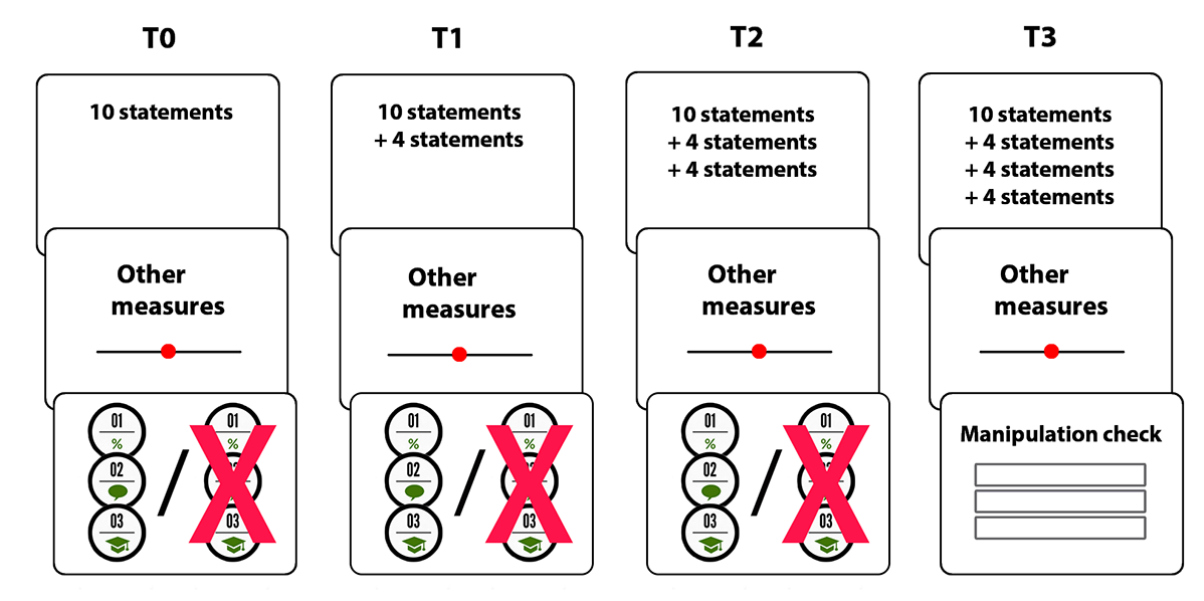
Figure 1. Flowchart of the main elements of the procedure per wave. Participants first completed the measure of belief accuracy, then completed other measures, and, finally, were exposed to the intervention or not. At T3, participants completed a manipulation check. The bottom panels of the first three columns display the intervention condition (left; infographic) and the control condition (right; no intervention). T0: baseline; T1: first follow-up wave; T2: second follow-up wave; T3: final